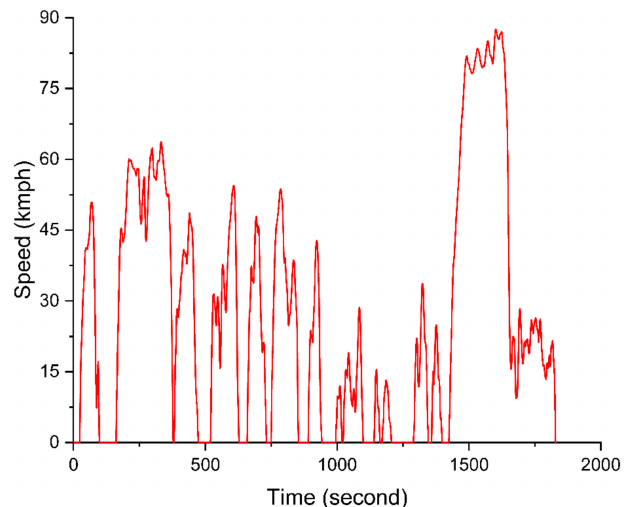
Figure 16. Speed-time profile of the JE05 driving